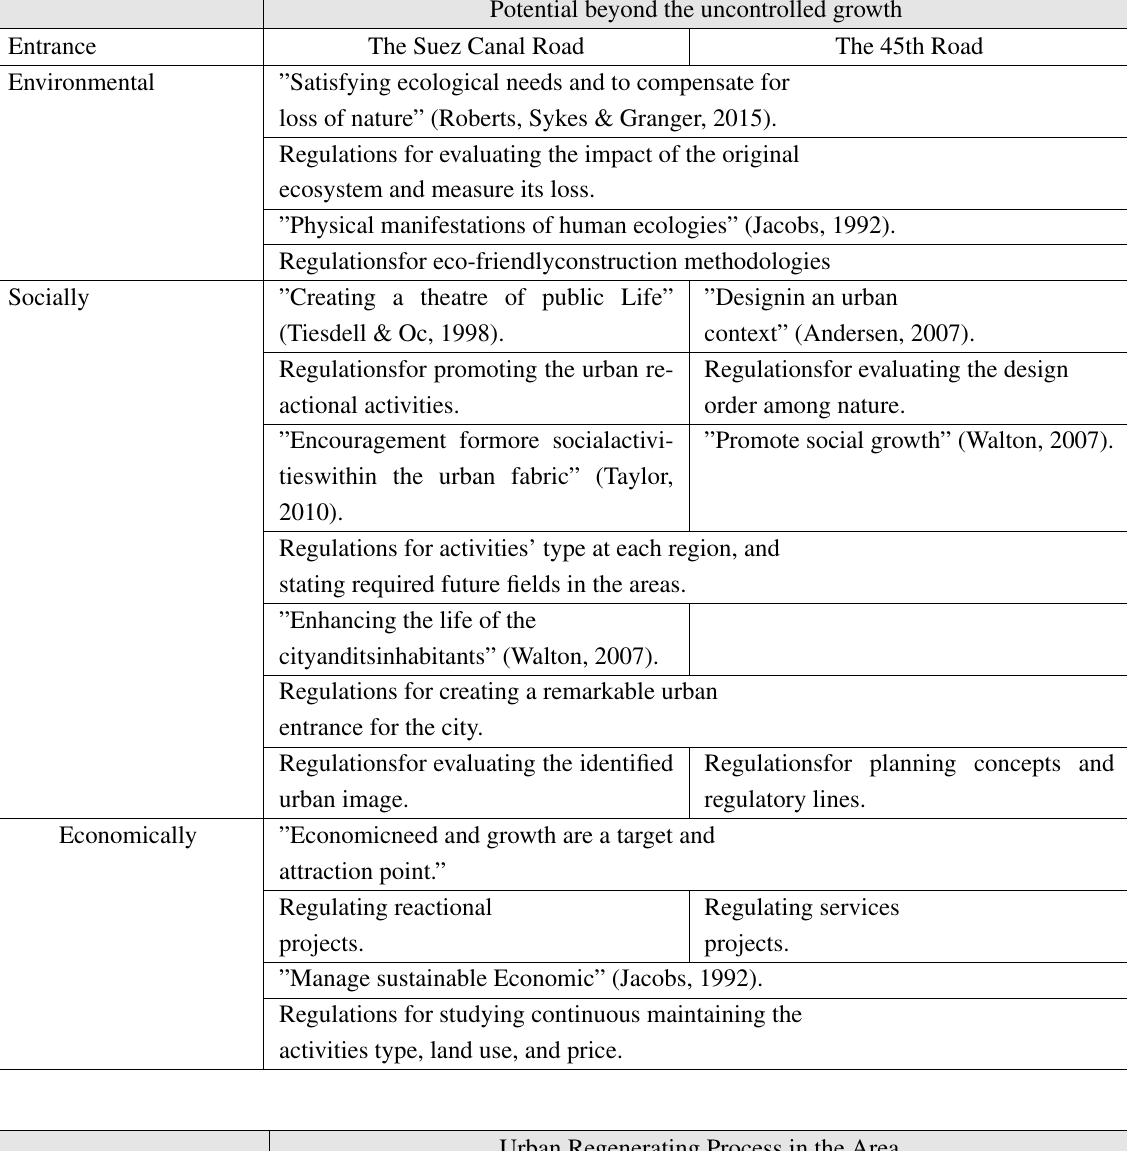
Table 2. A framework for urban regeneration process at the region of Alexandria city two